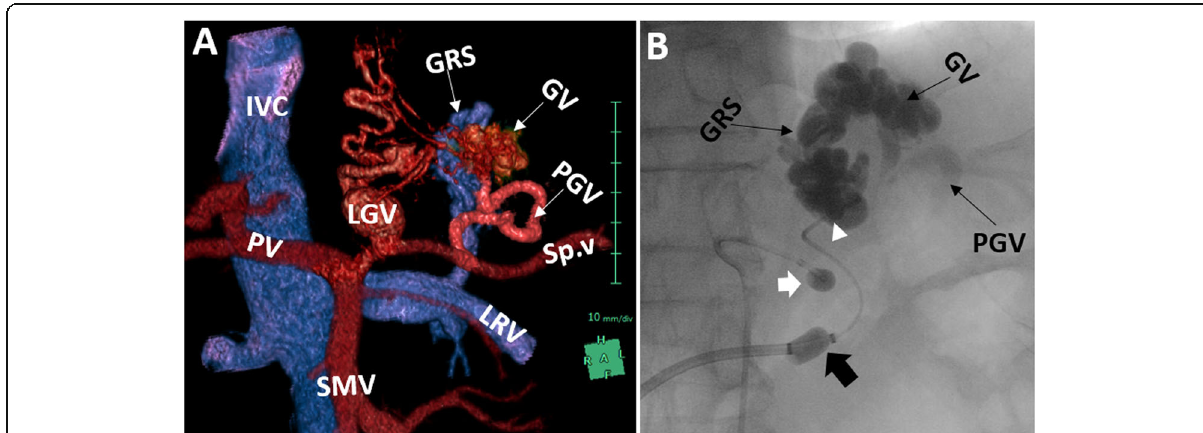
Fig. 2 Conventional BRTO technique. a C olor-coded volume rendering image obtained from pre-BRTO CE-CT portal phase images shows gastric varices (GV) supplied mainly from posterior gastric vein (PGV) and small branch from left gastric vein (LGV) and drained by gastrorenal shunt (GRS). b Fluoroscopic image obtained at the end of BRTO shows 9F Balloon occlusion guiding catheter positioned at the base of the GRS (black solid arrow) through which a 5F balloon catheter was advanced till the mid part of the GRS (white arrowhead). The distal and mid parts of the GRS, GV, and part of the PGV were totally opacified with EOI. Noted splenic artery balloon occlusion catheter (white solid